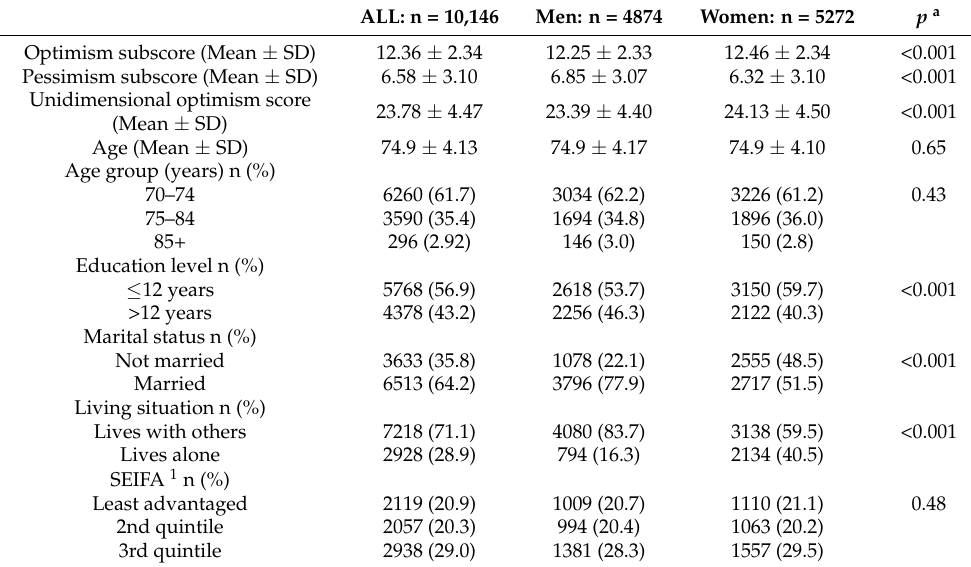
Table 1. Characteristics of 10,146 men and women aged 70 years and